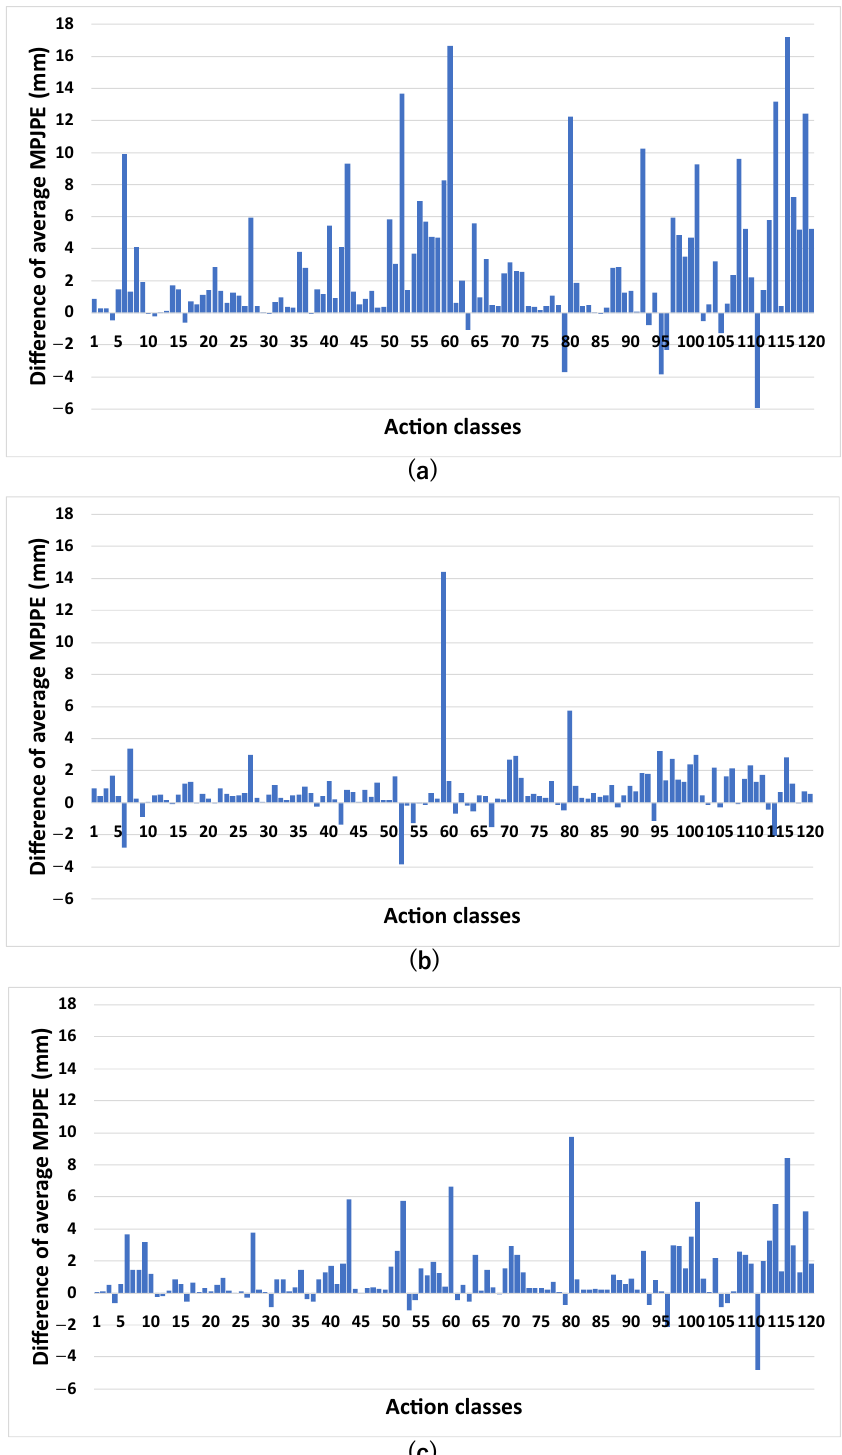
Figure 7. Differences in the class-wise average MPJPE between MSR-GCN and the models of MSR- GCN with IAA calculated. In this figure, ( a ) is the difference of MSR-GCN minus MSR-GCN with IAA P1, ( b ) is the difference of MSR-GCN with IAA P2 minus MSR-GCN with IAA P1, and ( c ) is the difference of MSR-GCN with IAA P3 minus MSR-GCN with IAA P1. Also, MSR-GCN with IAA P1 (2 FC layers), MSR-GCN with IAA P2 (3 FC layers), and MSR-GCN with IAA P3 (2 FC layers) are